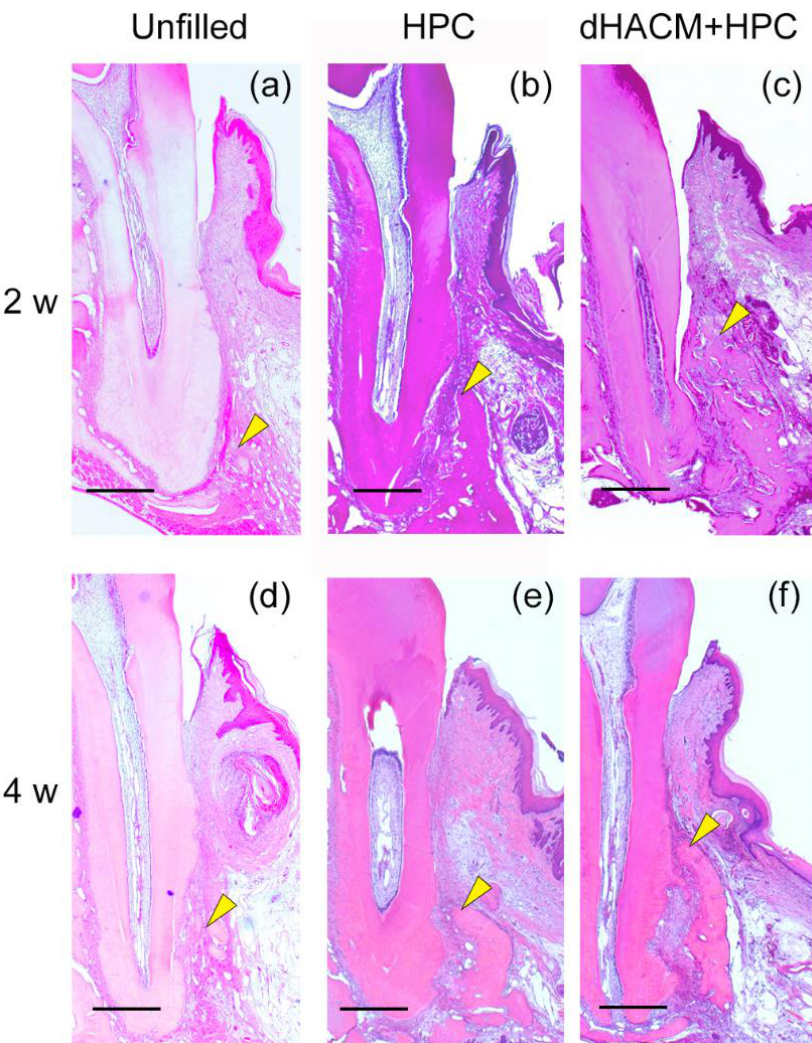
Figure 2. Histopathological overview (H-E staining). At 2 weeks, spaces in the defect are filled with newly formed connective tissue. ( a , b ) New bone formation is not observed in the Unfilled and HPC group. ( c ) In the dHACM+HPC group, newly formed bone can be observed from the tooth side of the intrabony defect. ( d ) At 4 weeks, new bone formation appeared minimal in the Unfilled group. ( e ) Newly formed bone was observed near the root side of the defect in the HPC group. ( f ) The extent of newly formed bone in the defect area in the dHACM + HPC group appeared to be greater than other groups. Yellow arrowheads indicate the coronal extent of newly formed bone. Original magnification ×25, bar = 500 µm.